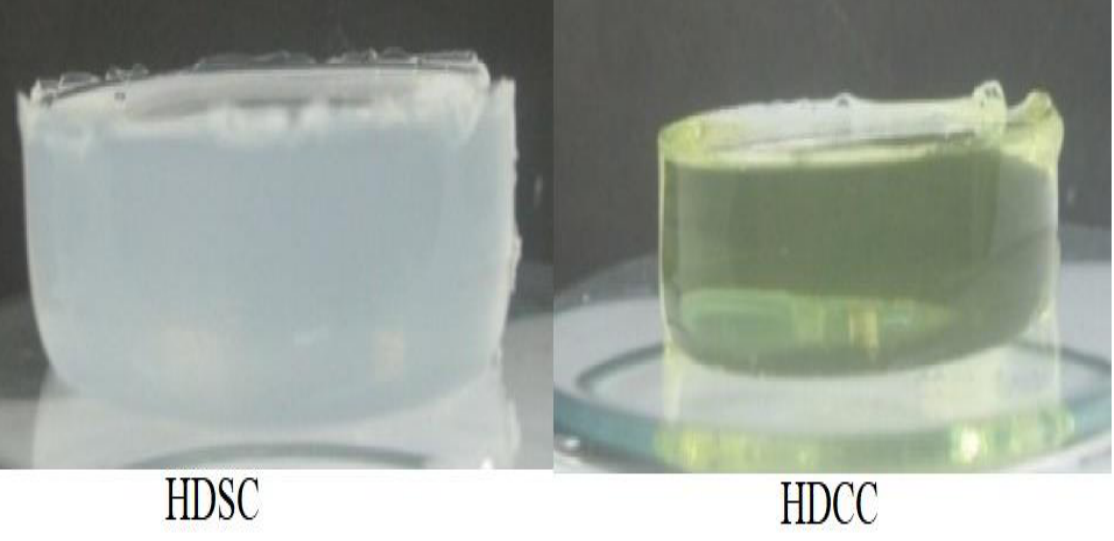
Figure 1. Appearance of white hydrogel ( left ) and hydrogel containing calendula extract (10%) after the free radical polymerization reaction ( right ).